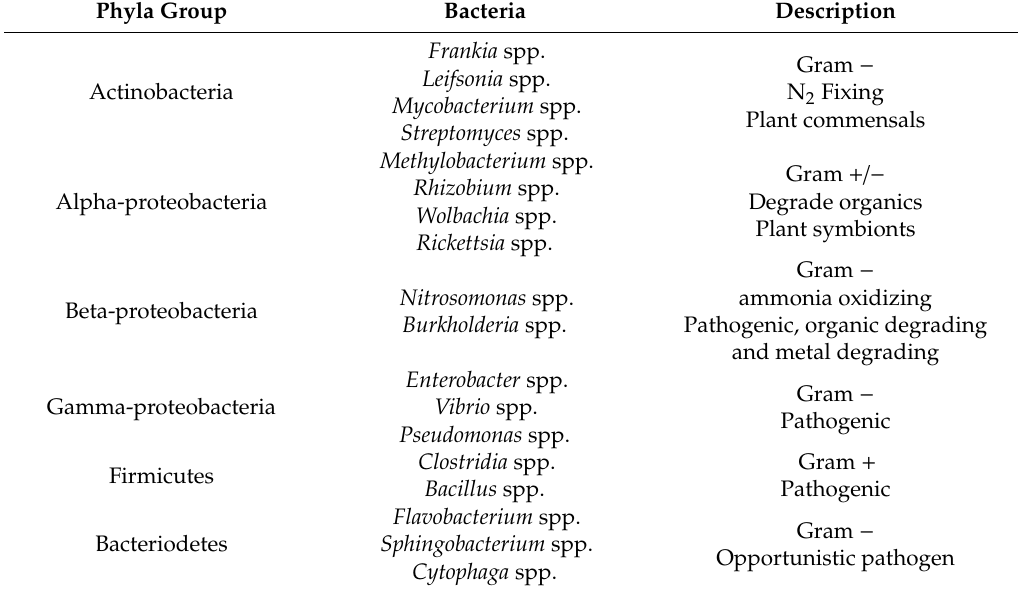
Table 3. Common microbial diversity and bacteria examples in aquaponics systems. Phyla Group